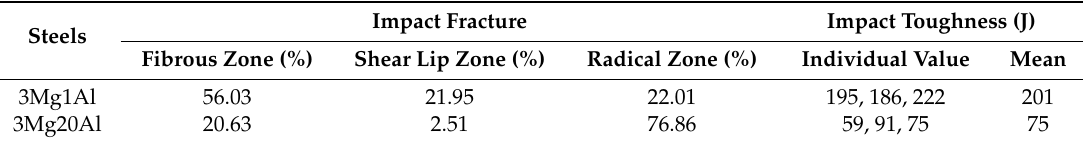
Figure 10. Fracture morphology features of HAZs. ( a – c ) 3Mg10Al; ( d – f ) 3Mg20Al. Table 3. Results of the quantitative statistical analysis of fracture surfaces and Charpy absorbed energy of HAZ at − 20 °C.